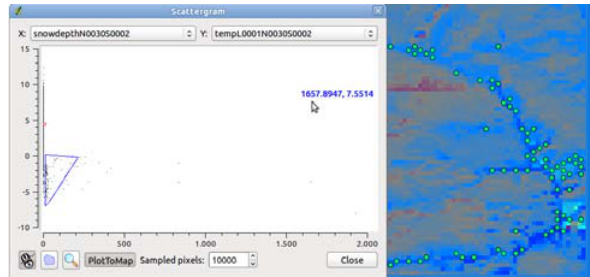
Figure 6. The scattergram (left) and terrain (right) showing snow-depth versus temperature 1